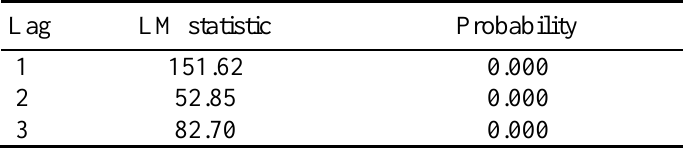
Table 2. The results of the LM test Lag